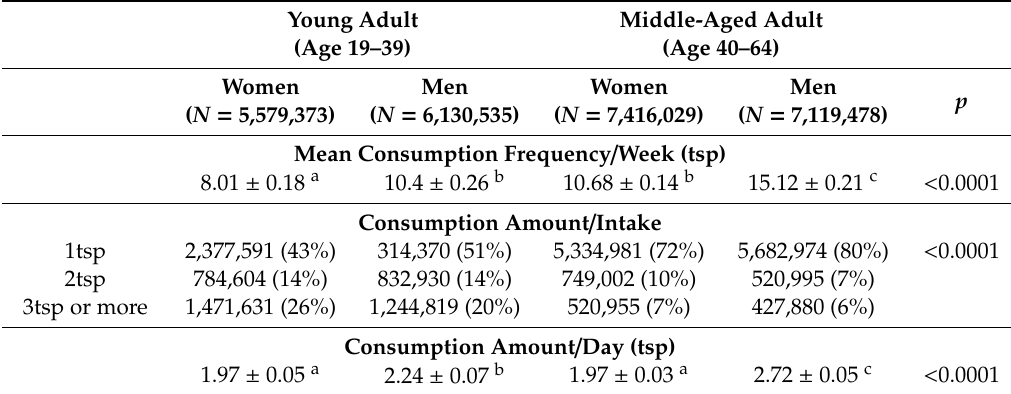
Table 2. Pattern of co ff ee intake among Korean adults.